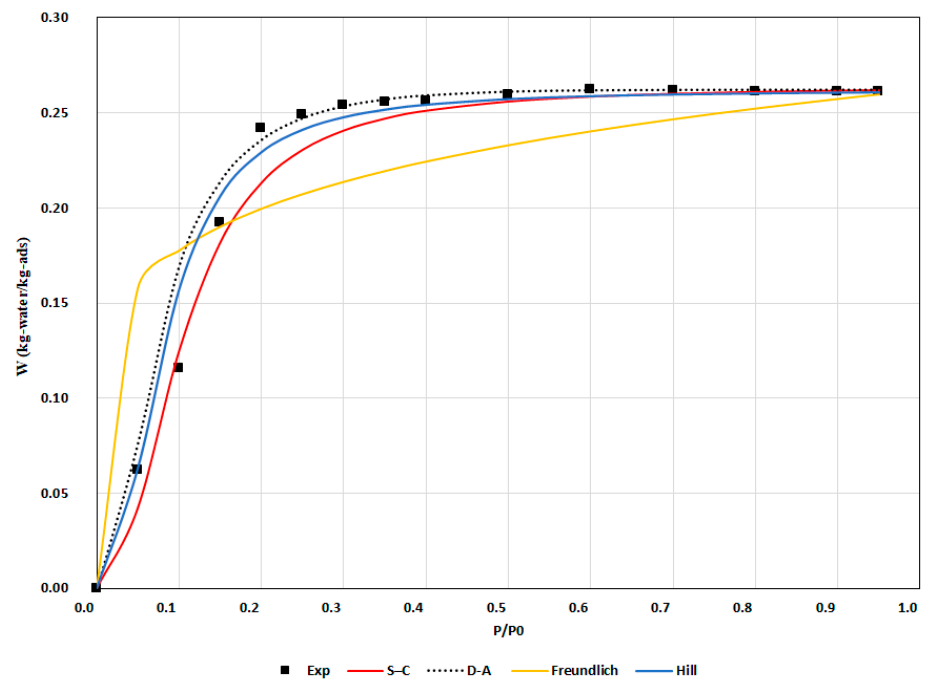
Figure 11. Water uptake comparison between experimental and isotherm model results at 70 °C. Table 2. SAPO-34 isotherm parameters for different models.